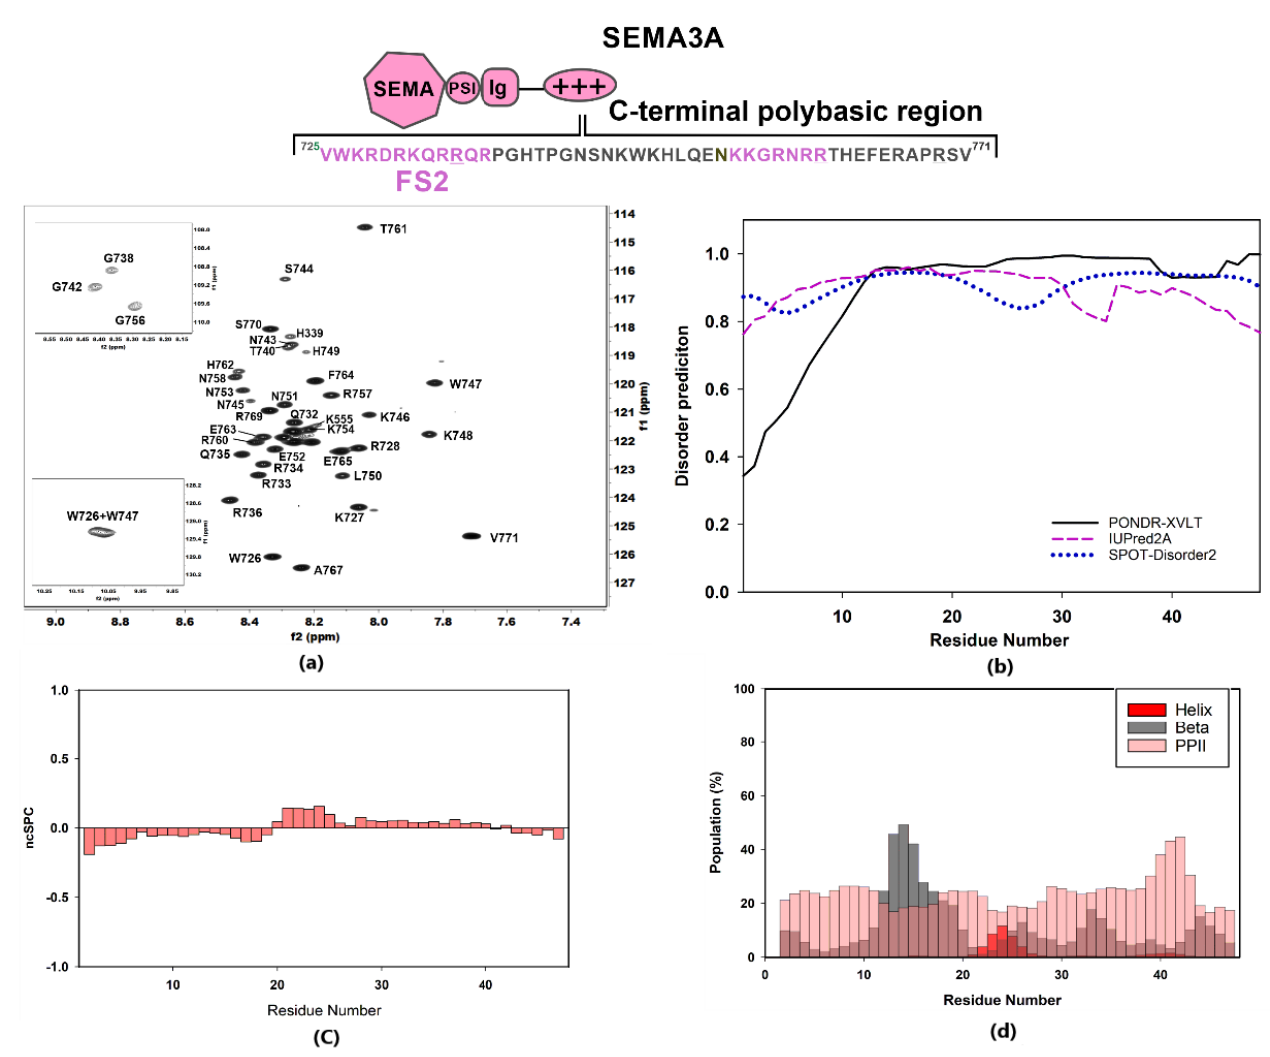
Figure 2. Structural characterization of Sema3A C-terminal domain. The scheme shows the amino acid sequence for Sema3A C-terminal region (SCT WT ) and the peptides studied in our previous work (labeled in dark rose) [40]. For these Sema3A peptides, we used the terms FS2 and (N)FS3 (for Furin processing sites 2 and 3). ( a ) [ 1 H, 15 N]-HSQC spectrum of 13 C, 15 N- labeled Sema3A C-terminal region at pH 5 (10 mM of acetate and 50 mM of NaCl, 298 K) with the assignment for backbone amides. ( b ) Bioinformatics analysis of the intrinsic disorder predisposition of the Sema3A C-terminal region obtained using IUPred2A, PONDR ® VLXT, and SPOT-Disorder2. Disordered segments are indicated by values higher than the default cut- off (0.5), lower values predict structured regions. ( c ) Structural propensity plot using ncSPC (neighbor connected structural propensity plot). ( d ) Estimation of secondary structure populations using δ 2D. Red bars indicate helical population estimate, grey bars indicate beta population estimates, dark rose bars indicate PPII population estimates, and remaining white is % of random coil. Chemical shift values for HN, N, C’, C α , and C β nuclei were used for ( c , d ) graph